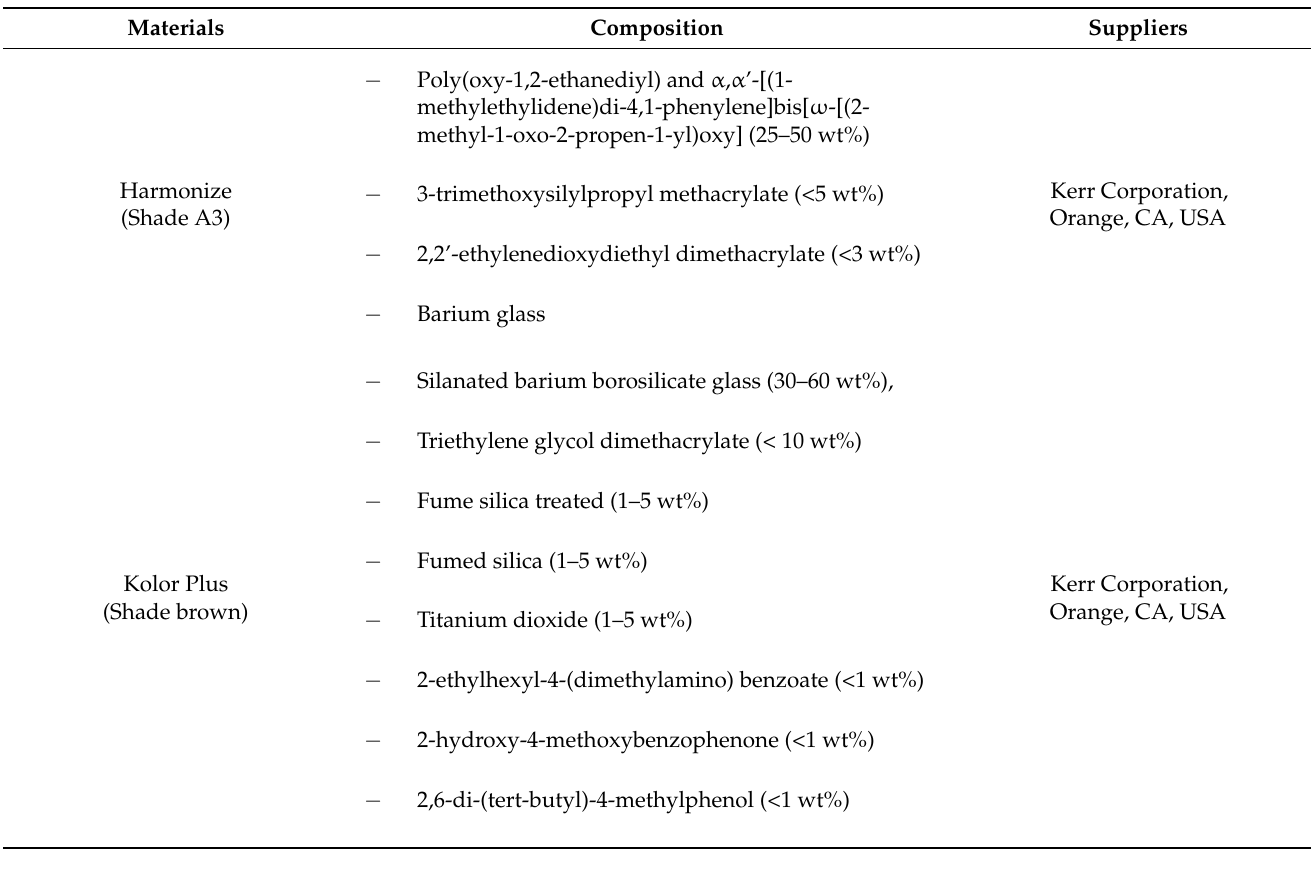
Table 1. The composition of the commercial materials used in the current study. The exact amount is not provided by the manufacturer.